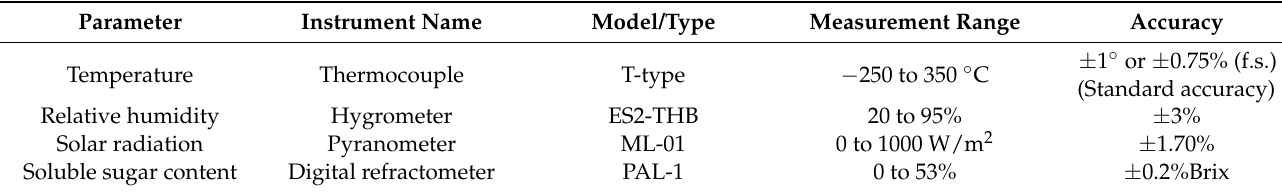
Table 2. Specifications of sensors and accuracy.